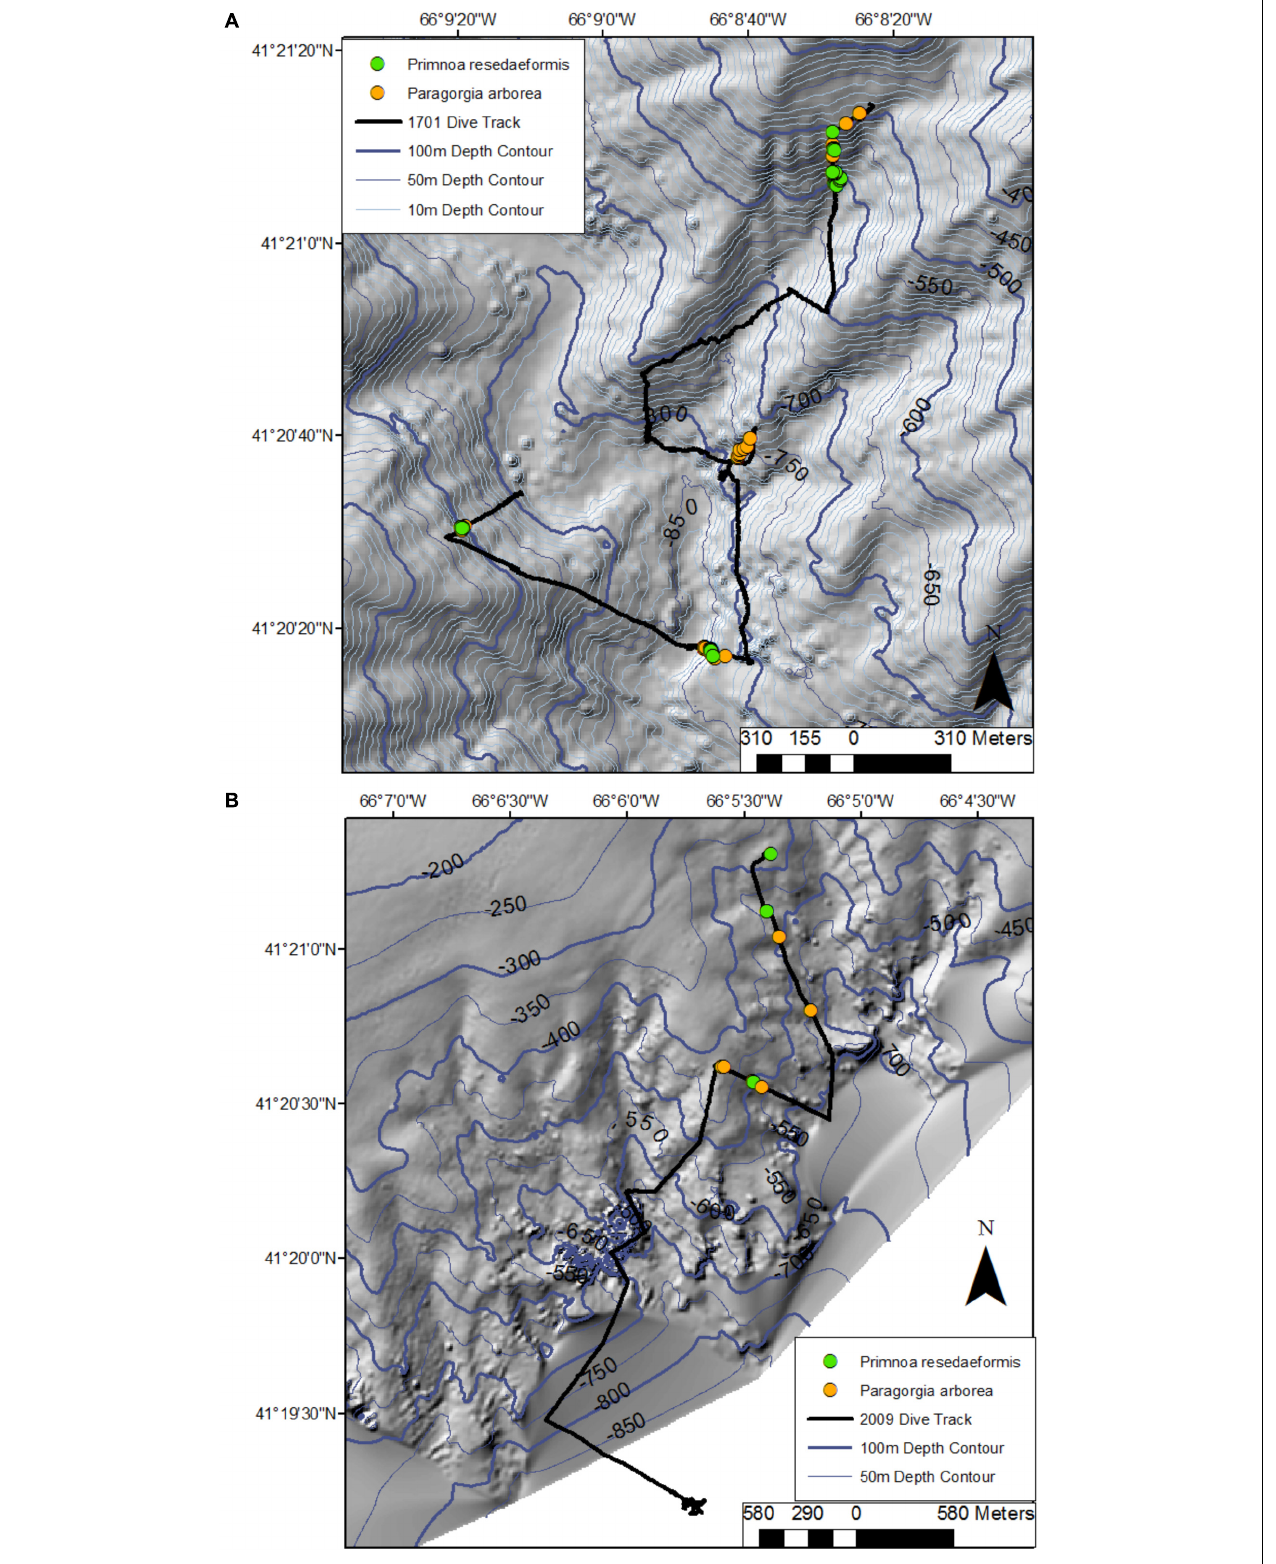
FIGURE 4 | Location of colonies of Paragorgia arborea and Primnoa resedaeformis along the dive tracks in Corsair Canyon in 2014 (R1701) (A) and 2017 (R2009) (B) . Bathymetric data provided by the Canadian Hydrographic Service, Fisheries and Oceans - Canada.